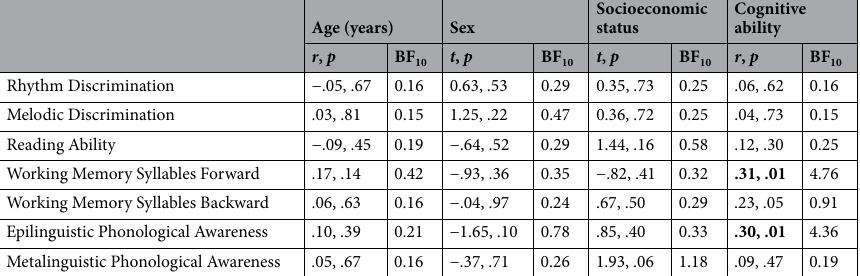
Table 2. Pearson correlations and independent sample t-tests between the main study variables—rhythm and melodic discrimination, reading ability, syllable working memory (forward and backward), and epi- and metalinguistic phonological awareness—and age, sex, socioeconomic status, and cognitive ability. N = 74 for all analyses, except for those involving Working Memory of Syllables, where n = 73 due to a missing value. Degrees of freedom (df) are equal to 72 for all independent sample t-tests, except for those involving Working Memory of Syllables, where df = 71 due to a missing value. Bold numbers indicate significant results.